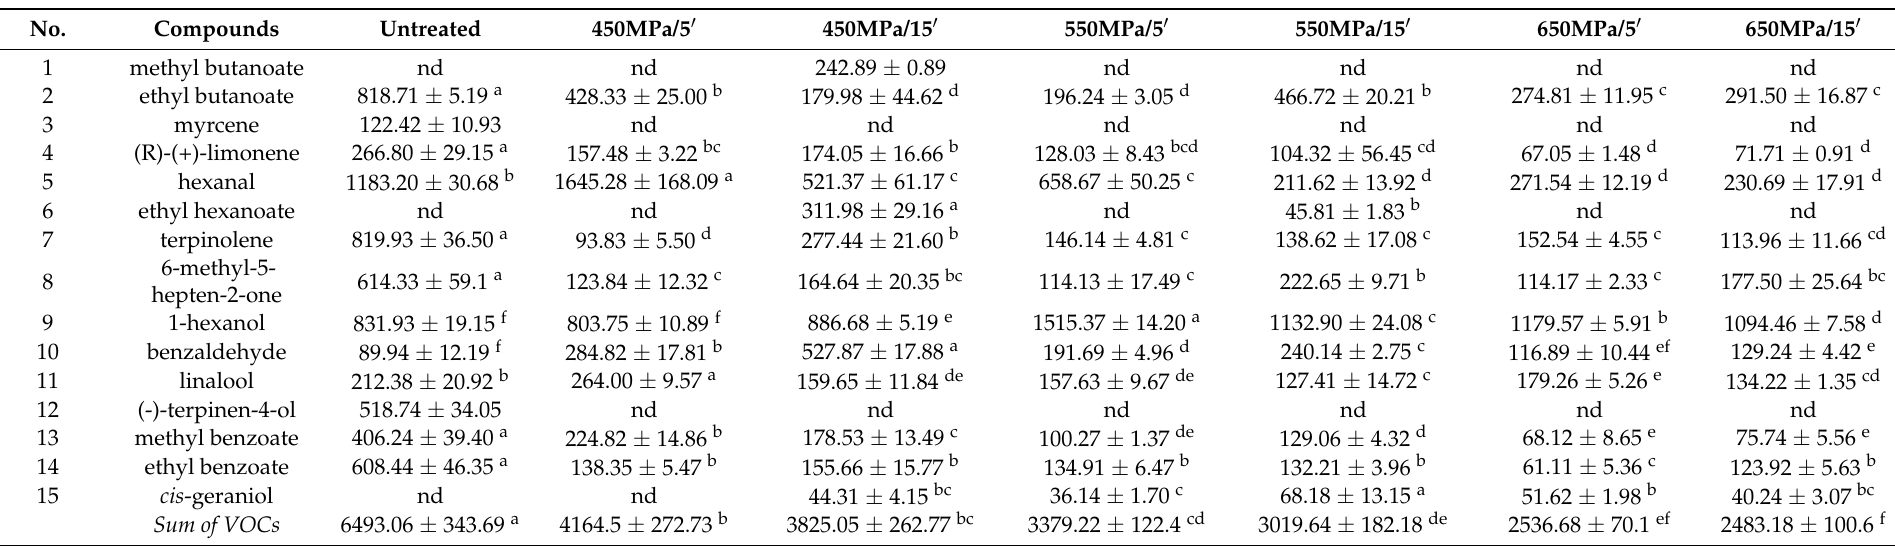
Table 3. The content of major VOCs estimated in the untreated and HHP-treated cv Geneva. Results are presented as µ g per kg of fruit.